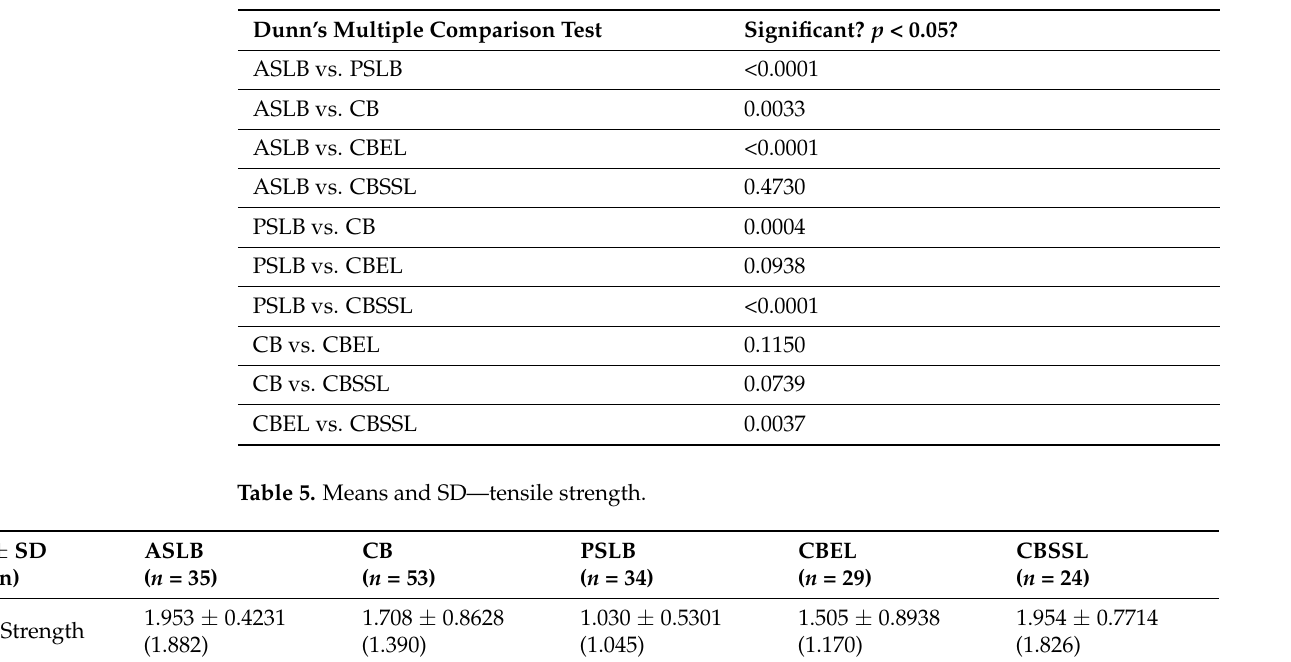
Table 4. Dunn’s post hoc test—load at maximum load.